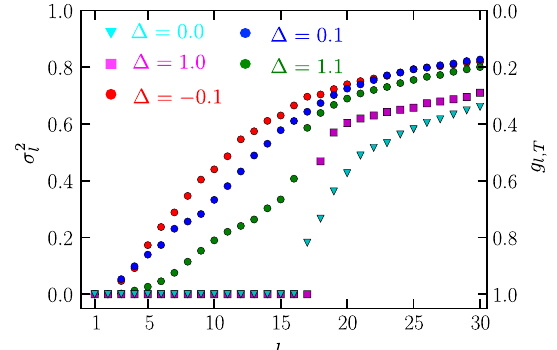
FIG. 7. Scatter plot of the smallest 30 squared singular values σ 2 and the plateau value g from Eq. (7.17) for a classical model l;T l (7.2) of N ¼ 16 spins at different values of the anisotropy Δ . We average σ 2 over N ¼ 10 3 random initial conditions f S 0 g and 10 l , and we set T ¼ disorder realizations for the fields f J i g 8192 J − 2 . At the integrable points Δ ¼ 0 (cyan triangles) and Δ ¼ 1 (magenta squares), we see N and N þ 1 zero singular values, respectively, corresponding to the conserved quantities that can be written as a sum over bilinear operators (7.10). These are separated from the rest of the singular values by a “ spectral ” gap. At Δ ¼ − 0 . 1 (red circles), Δ ¼ 0 . 1 (blue circles), and Δ ¼ 1 . 1 (green circles), we see two precisely zero singular values 2 , along with the corresponding to the conservation of H and ð S z tot Þ lift-off of the other N − 2 singular values. For Δ ¼ 1 . 1 , the first N singular values are also separated by a spectral gap from the rest. And, although for Δ ¼ − 0 . 1 and Δ ¼ 0 . 1 the spectral gap is not visible, one can still see a rounded “ cusp ” occurring around l ¼ N — this cusp suggests that there still exist slow modes Q for l l ¼ 3 ; … ; N